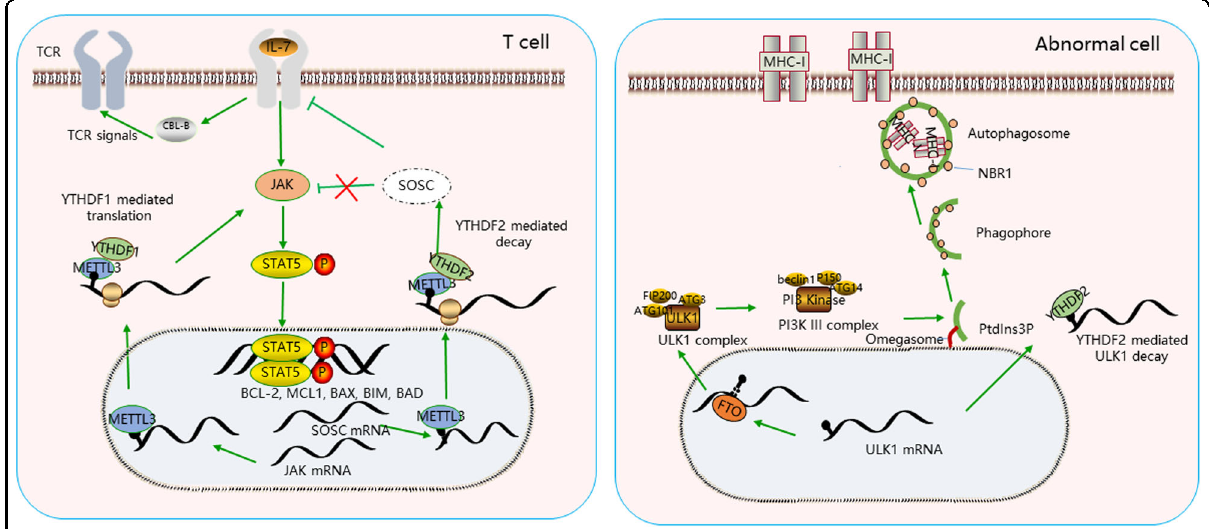
Fig. 3 The m6A alters adaptive immunity evasion. The m6A plays a critical role in T cell maturation, differentiation (left); M6A regulates MHC class I appear on the surface of cancer cells by changing the process of autophagy